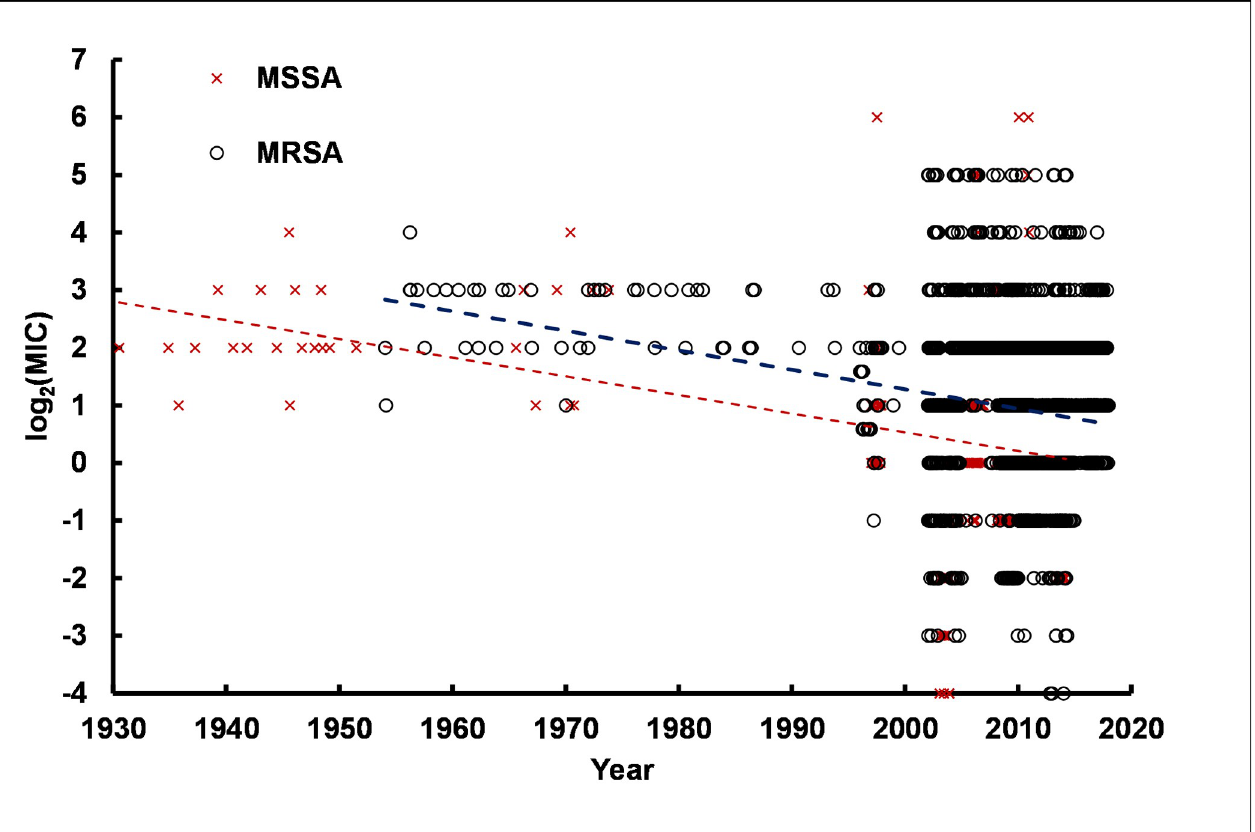
Fig 9. Susceptibility of S . aureus to CHX over time. Two sets of results are shown: Strains specified as MRSA (dark blue open circles) and strains specified as MSSA (dark red open circles). Corresponding representative linear regression lines are shown as dashed lines in the same colors as the symbols. Details of linear regression analyses are given in S20 and S21 Tables in S2